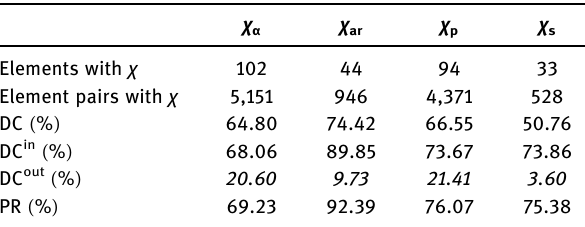
Table 6: Relative value analysis between element electronegativity and node importance ( where the values in italics are